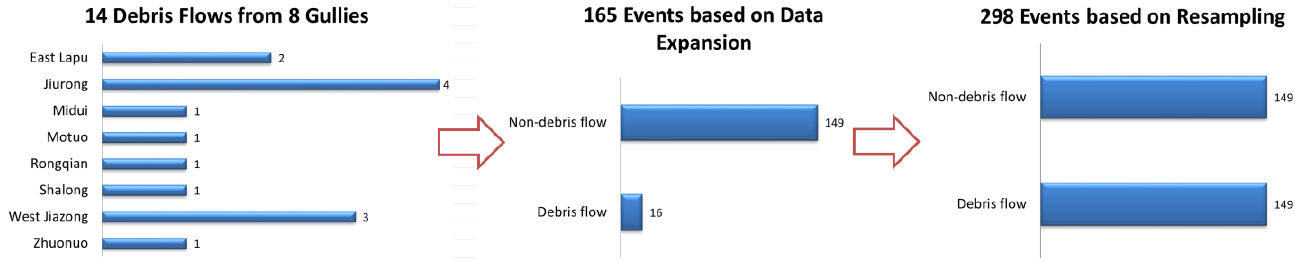
Figure 2. The preparation process of the data set for training and validation.